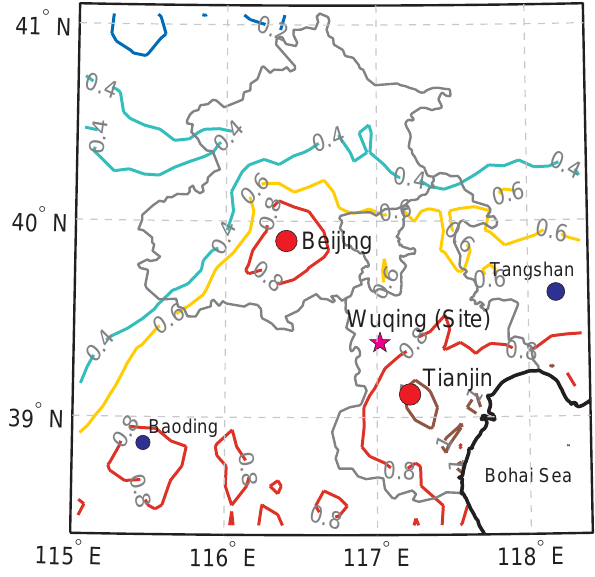
Fig. 1. Map shows the site location (red star), major cities in the vicinity (red and blue circles) and contour lines of the 4-yr av- erage MODIS AOD (Aerosol Optical Depth) distribution (2005– 2008, 0 . 1 ◦ × 0 . 1 ◦